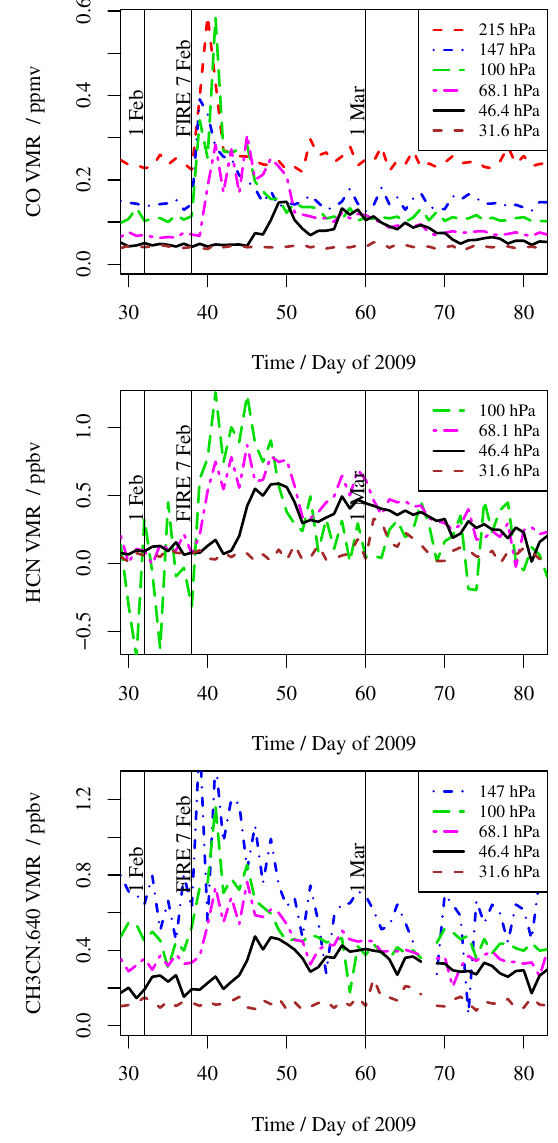
Fig. 5. Time series of the mixing ratio of MLS CO, HCN and CH 3 CN within the polluted airmass. The CH 3 CN shown is that derived from the 640GHz